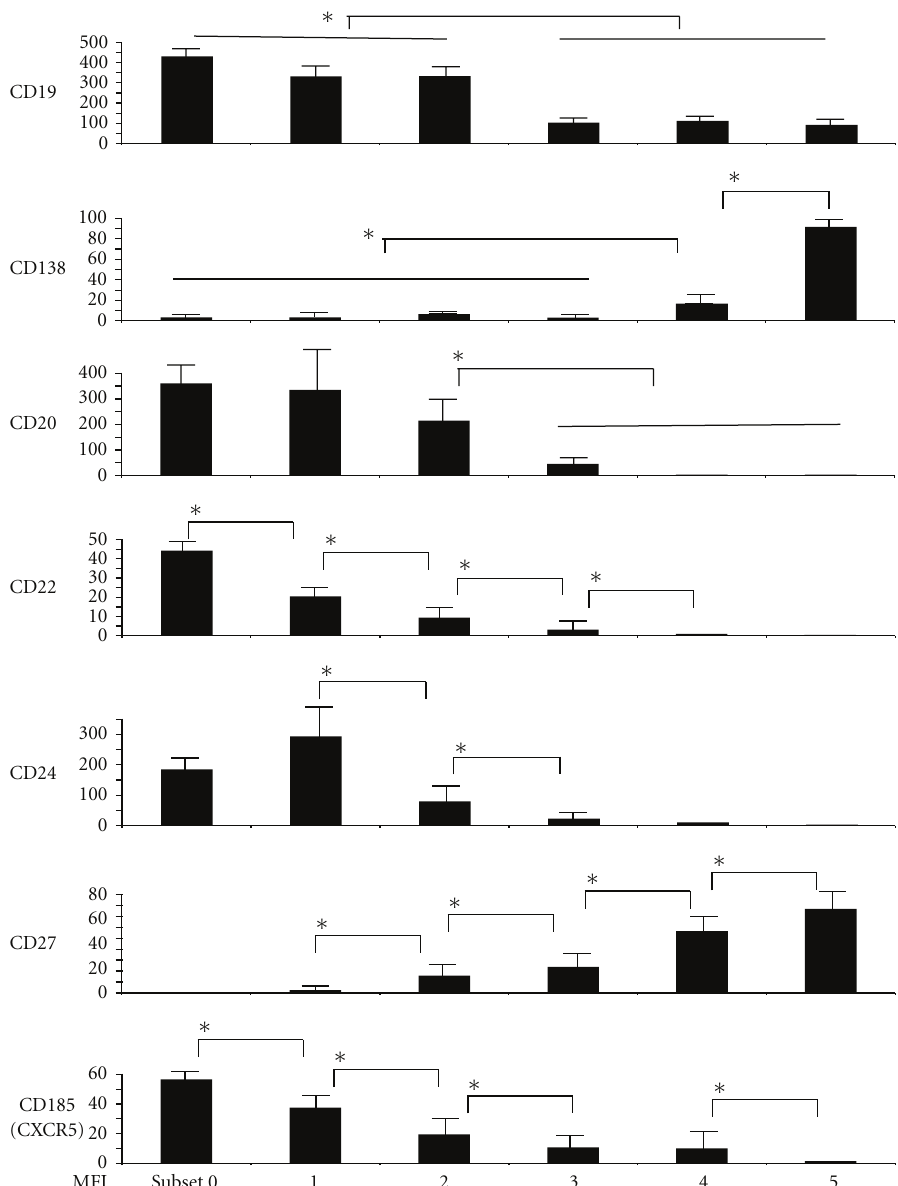
Figure 3: Expressions of important B cell markers (MFI) on RP105( − ) B cells (subset 1–5) and RP105(+) B cells (subset 0). The levels of CD19, CD20, and CD24 were significantly lower in subset 3, 4, and 5 B cells compared to subset 0, 1, and 2 B cells ( P < 0 . 05). CD27 and CXCR5 expression was significantly di ff erent: ( P < 0 . 05 subset 0 versus 1, subset 1 versus 2, subset 2 versus 3, subset 3 versus 4, and subset 4 versus